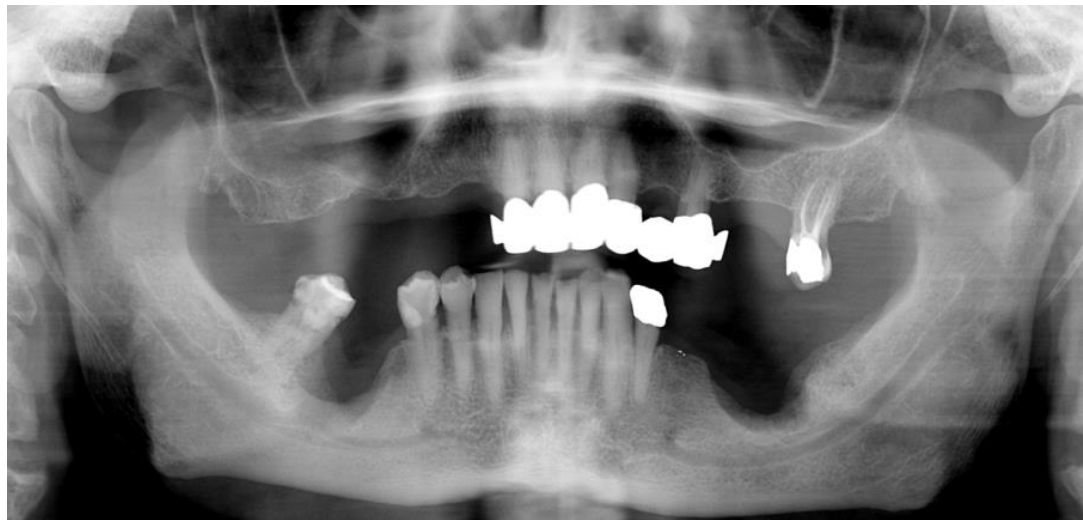
Figure 7. The 3-month postoperative panoramic radiograph.